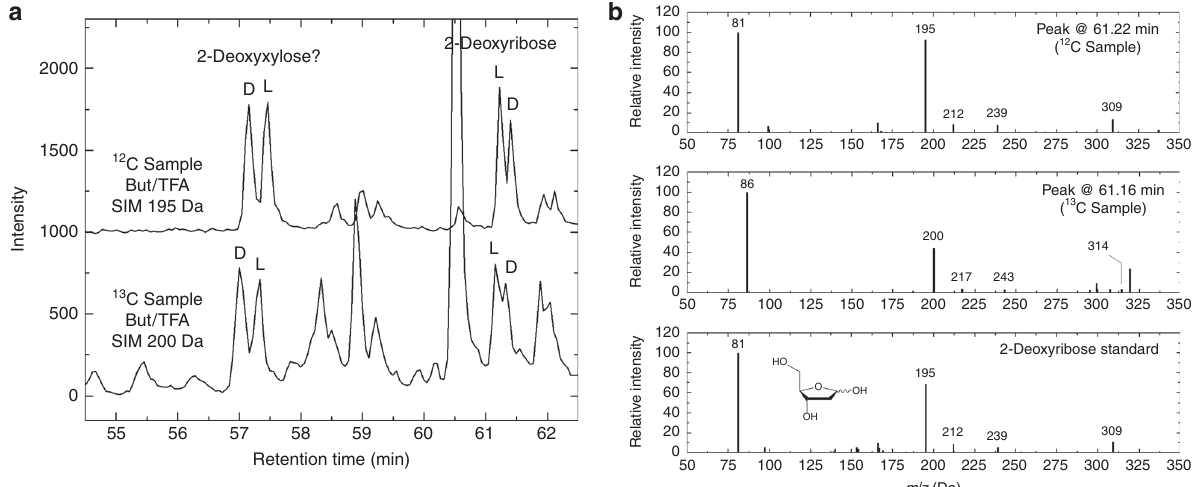
Fig. 1 Identi fi cation of 2-deoxyribose in ice photolysis residues. a Single-ion monitoring (SIM) chromatograms of residues produced from the UV irradiation of H 2 O:CH 3 OH (2:1) ( 12 C sample, m / z = 195 Da) and H 2 O: 13 CH 3 OH (2:1) ( 13 C sample, 200 Da) ice mixtures after derivatization with ( + )-2-butanol/TFAA. The peaks around 57.0 and 57.3 min in both chromatograms are tentatively assigned to 2-deoxyxylose (see Supplementary Fig. 2). Intensities are offset for clarity. b From top to bottom, mass spectra of the peaks assigned to 2-deoxy- L -ribose in the regular residue, the 13 C-labeled residue, and a standard of 2- deoxyribose. The molecular structure of 2-deoxyribose is shown without derivatization. Assignments of the fragments in the mass spectra can be found